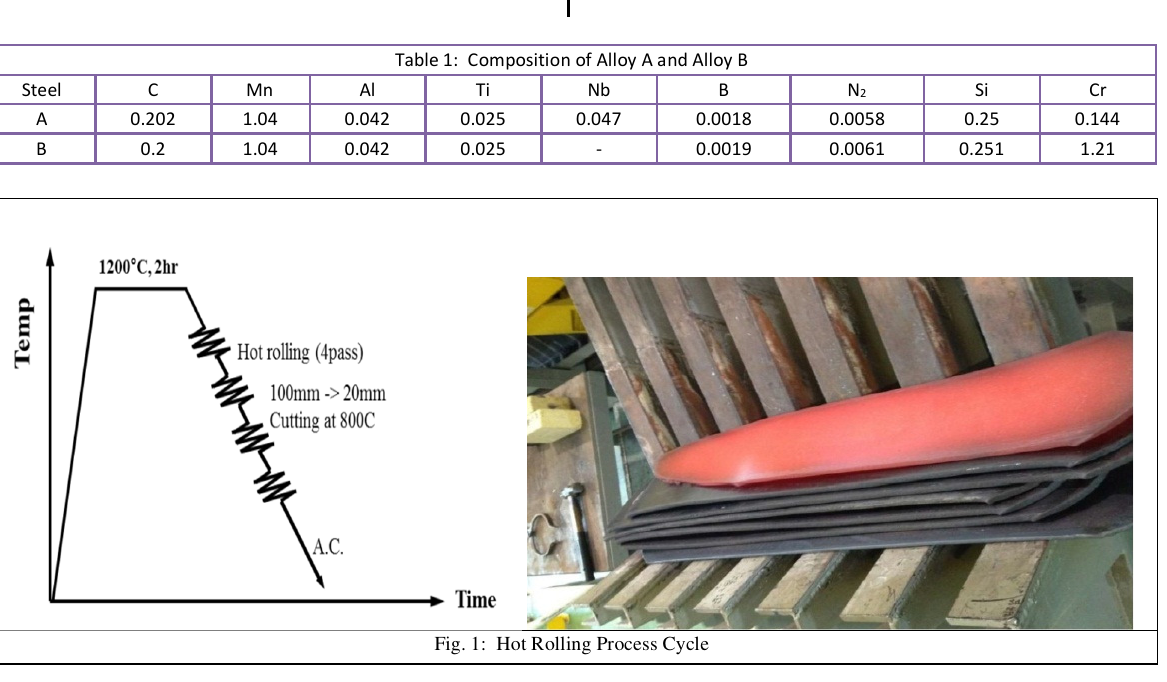
Fig. 1: Hot Rolling Process